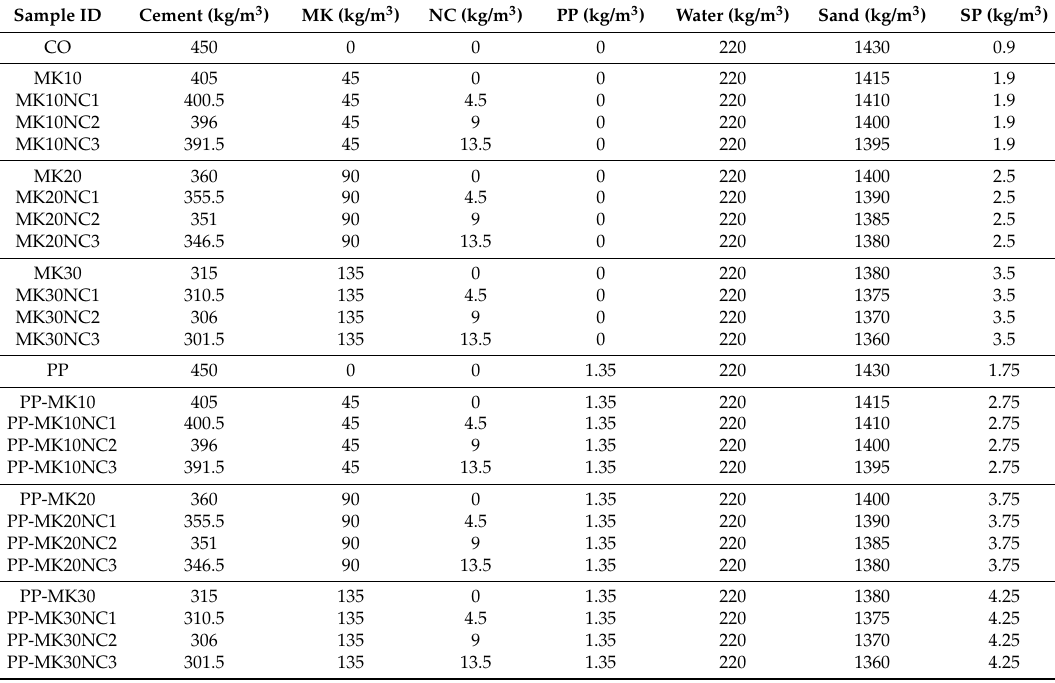
Table 4. Mix details of